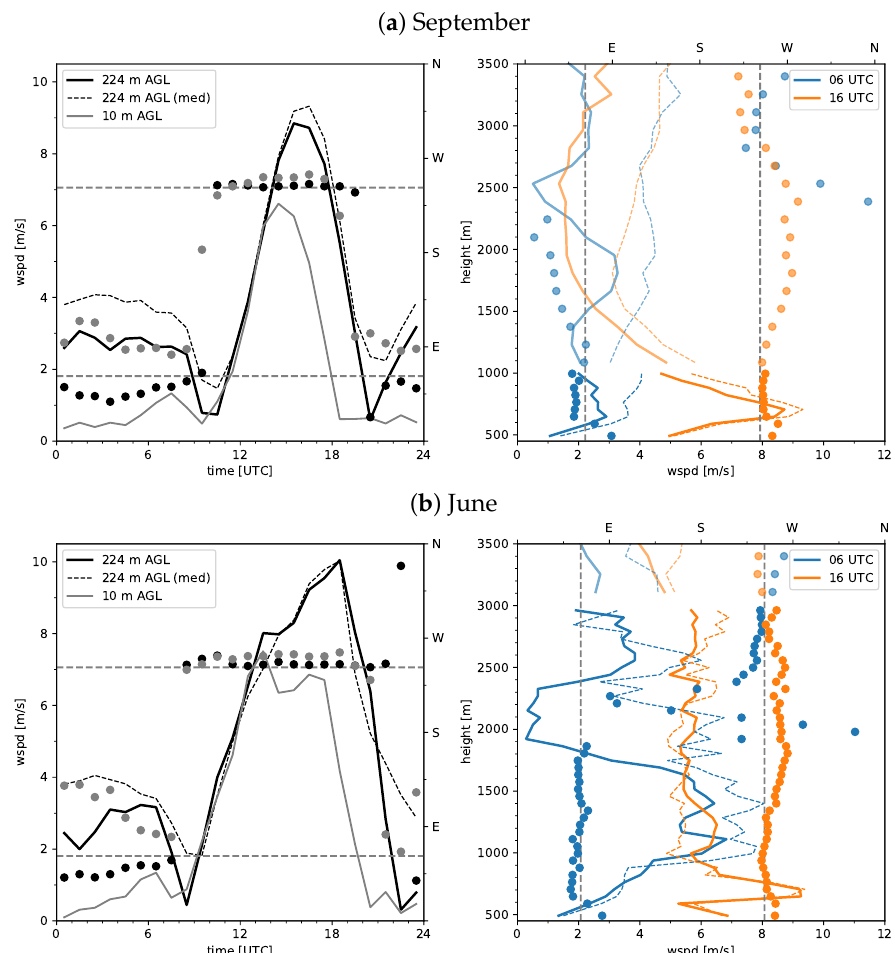
Figure 13. Left column : Mean diurnal cycle of the valley wind (vector-averaged) measured by the weather station (10m AGL) and by the low-mode wind profiler (224m AGL) for the valley wind days in September 2016 and June 2017. Solid lines denote wind speed and symbols the wind’s direction. The thin dashed line represents the median wind speed at 224m AGL. Right column : Vector-averaged profiles of the wind at 6 UTC and 16 UTC for the same valley wind days. Thin dashed lines represent the median of the wind speed. For September (June), the low-mode wind profiler data is used for heights below 1000m MSL (3000m MSL), whereas at altitudes above 1000m MSL (3000m MSL), the high-mode wind profiler data is shown. The dashed line marks the valley’s